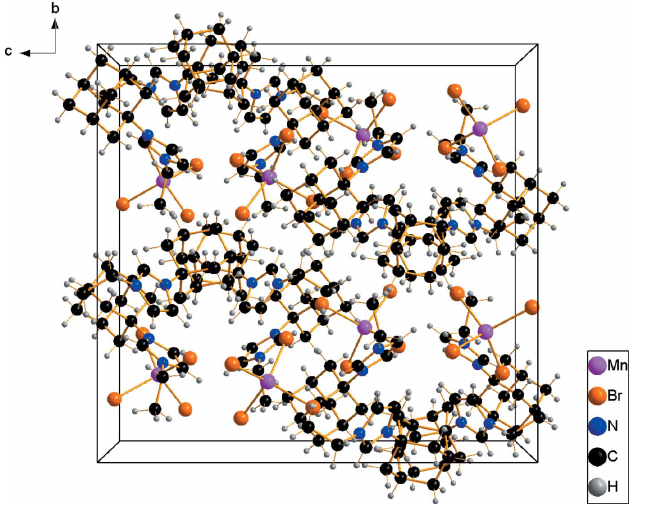
Figure 2 A view of the unit-cell contents in projection down the a axis.